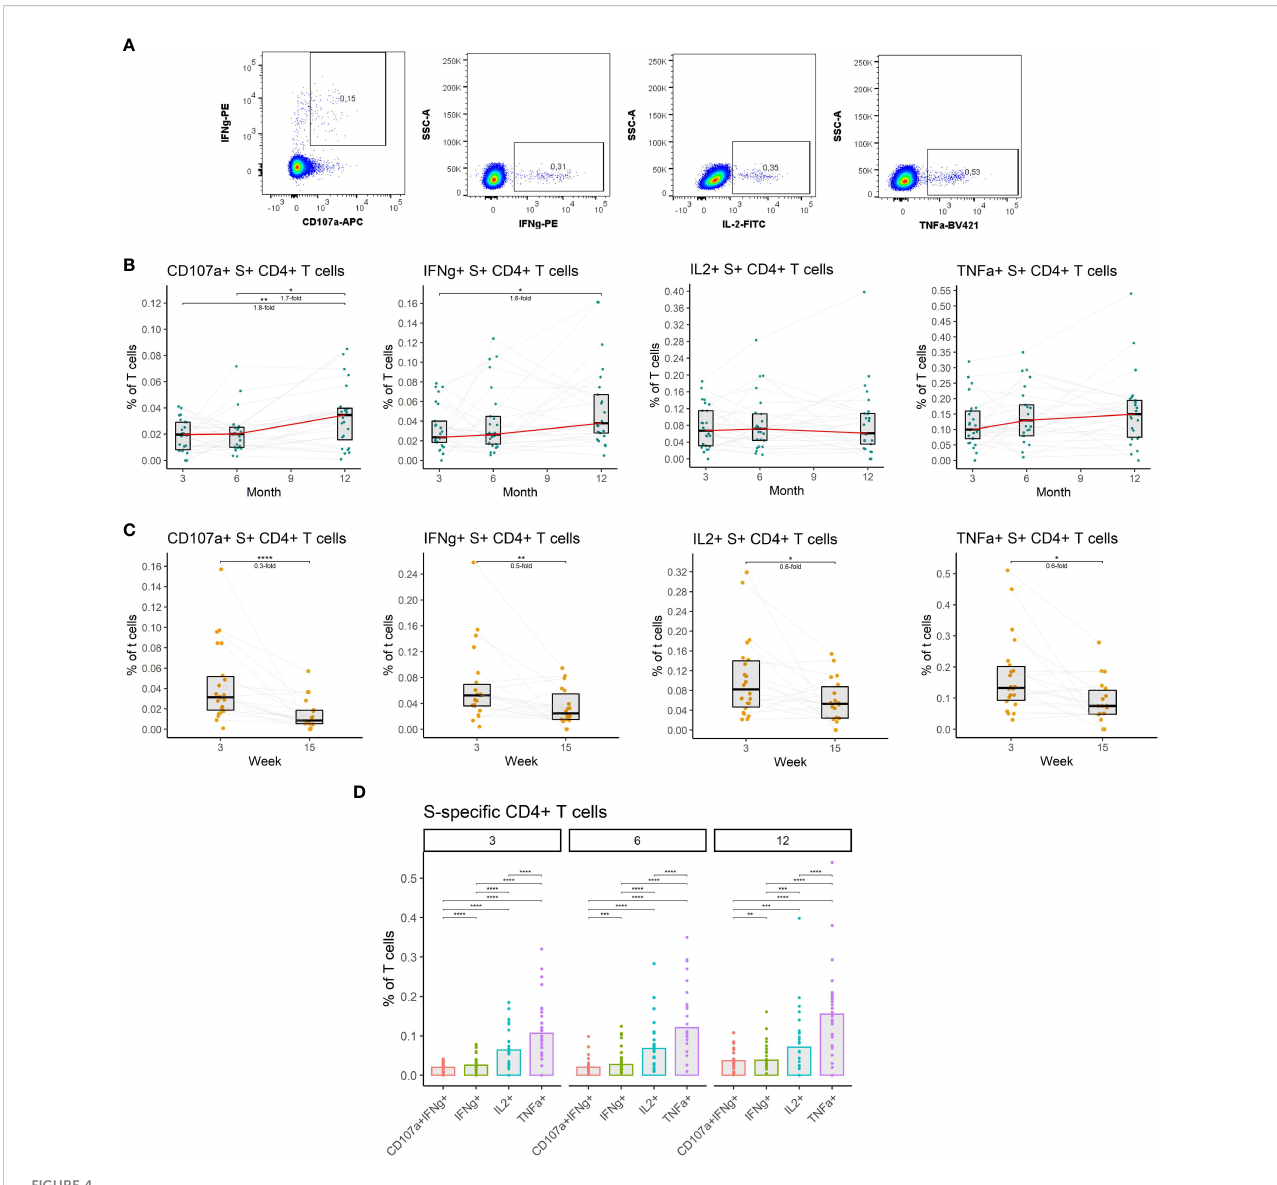
FIGURE 4 The dynamics of SARS-CoV-2-speci fi c CD4+ T cells after the initial and booster doses of mRNA vaccine. (A) Representative fl ow cytometry plots demonstrating the detection of S-speci fi c CD4+ T cells with different effector functions; cytotoxicity (CD107a and IFN g expression), IFN g expression, IL-2 expression, and TNF a expression. (B) The frequencies of S-speci fi c CD4+ T cells with different effector functions as a percentage of bulk T cells for months 3, 6, and 12 after the initial vaccination. The red line connects the median values of each time point. Fold change was calculated as a ratio of the medians of compared time points. (C) The frequencies of S-speci fi c CD4+ T cells with different effector functions in the peripheral blood of vaccinated individuals 3 to 15 weeks after the booster vaccination. (D) Comparison of S-speci fi c CD4+ T cell frequencies with different functions for months 3, 6, and 12 after the initial vaccination. Differences between the groups were assessed using the Wilcoxon test with Holm ’ s correction for multiple testing. *p<0.05, **p<0.01, ***p<0.001,